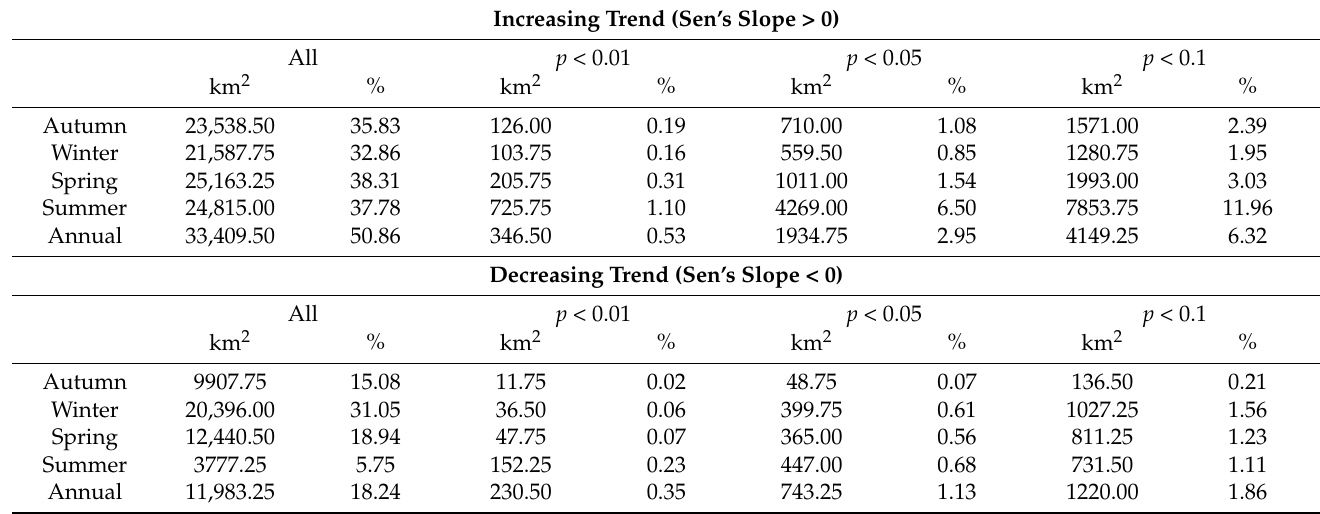
(Table A3) for the months of June and July. Table 3. Increasing and decreasing trend of SCD in the study area of Ladakh from 2000 to